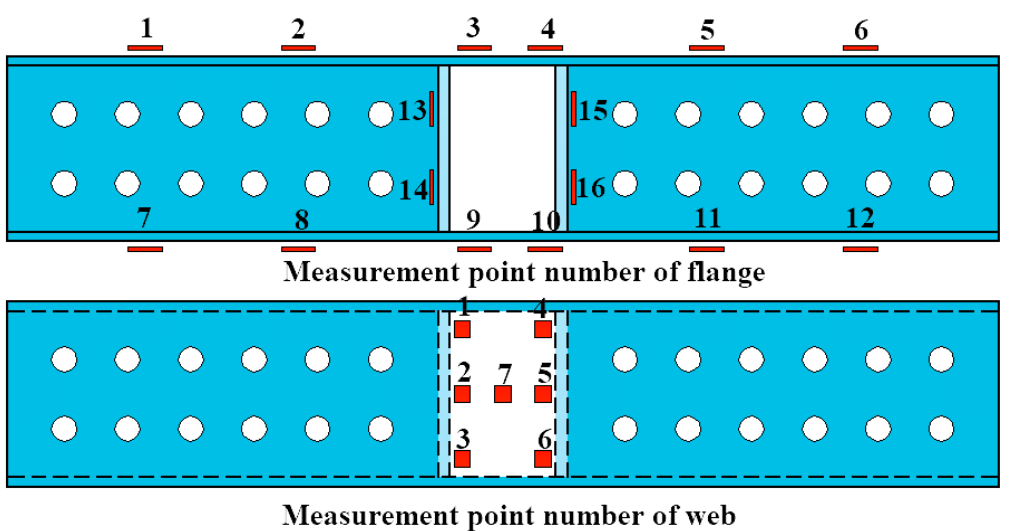
Figure 10. Measurement point number of RSL-1.